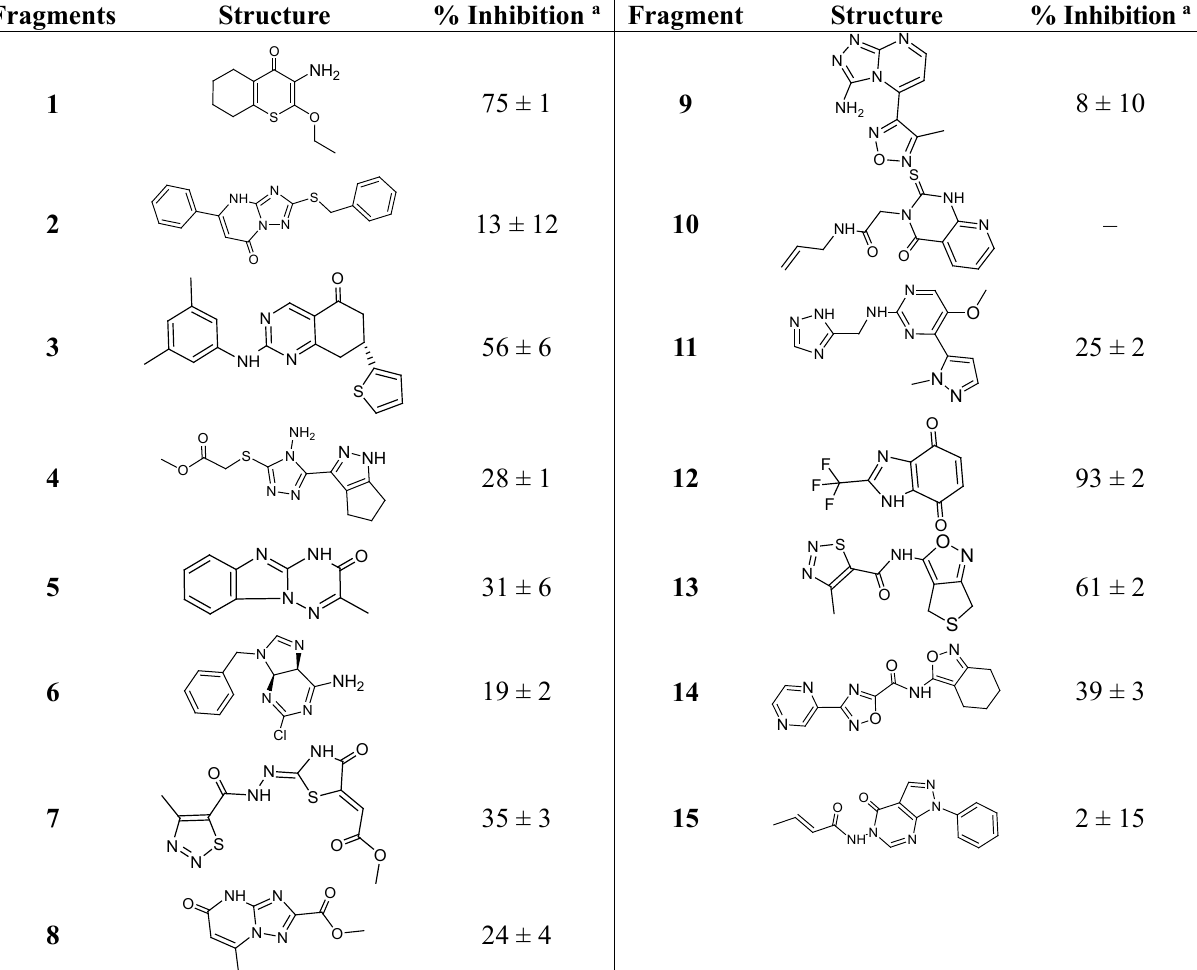
Table 2. The structure and effect of 15 fragments on Aurora-A inhibition. Fragments